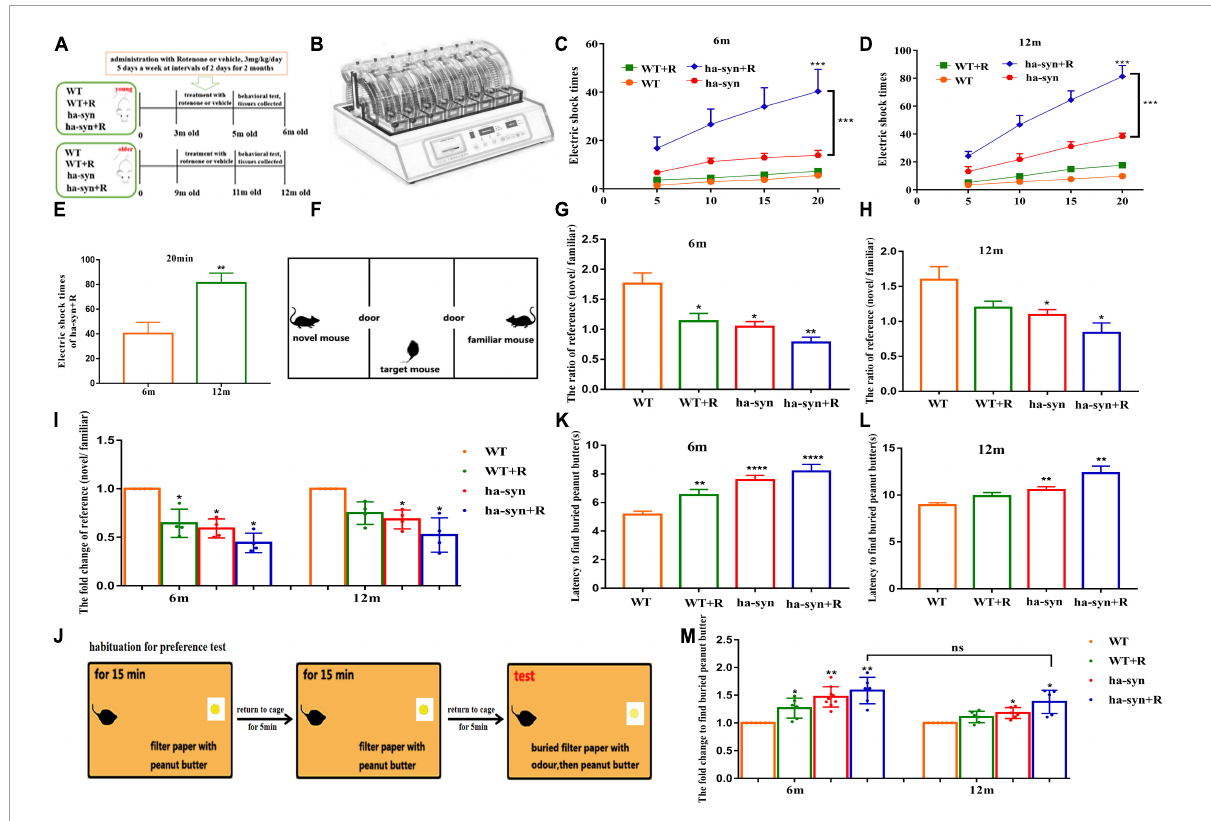
FIGURE1 Rotenone significantly impaired the motor and non-motor function of h α -syn + / − mice. (A) The experiment flowchart. Muscle endurance of mice was detected by wheeling test (B–E) . (B) Behavior paradigm of rotation wheel instrument. (C) The average number of electric shocks for 6-month-old h α -syn + / − mice at 5, 10, 15, and 20 min. (D) The average number of electric shocks of 12-month-old h α -syn + / − mice at 5, 10, 15, and 20 min. (E) The number of electric shocks of h α -syn + R mice during 20 min. Social recognition was detected using